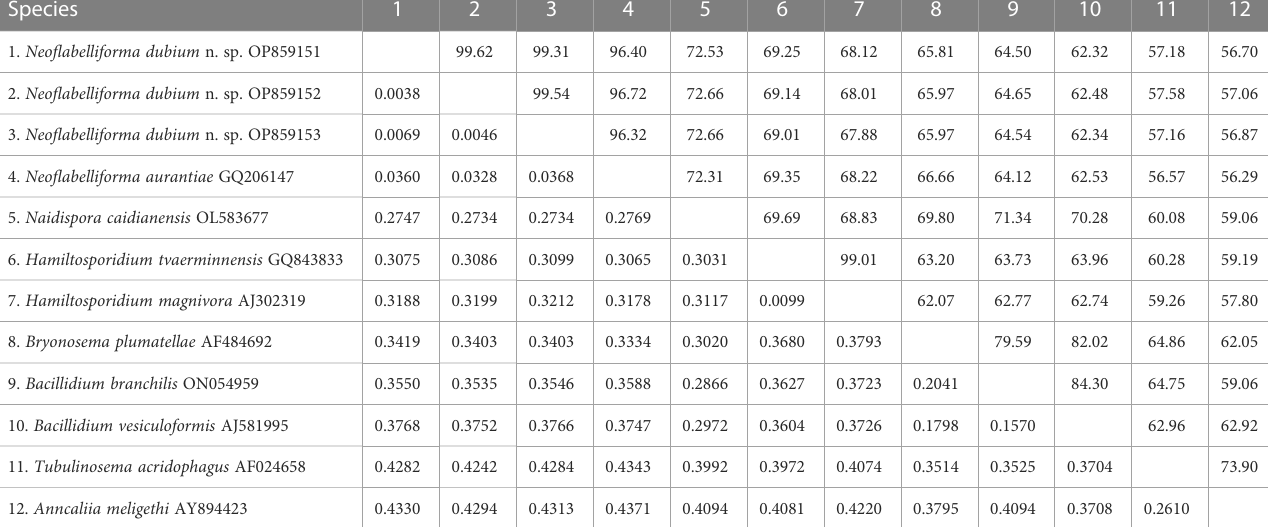
TABLE 3 Pairwise nucleotide sequence identity (upper right) values and evolutionary distances (left bottom) among Neo fl abelliforma dubium n. sp. isolates and 9 other microsporidium species with high sequence similarity by Kimura-2 Parameter analysis based on SSU rDNA sequences.